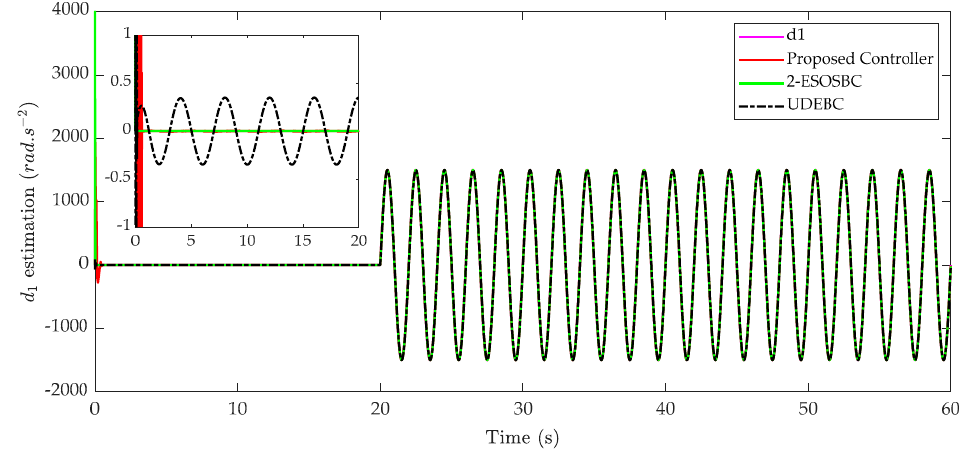
Figure 7. The estimation of the mismatched disturbance.